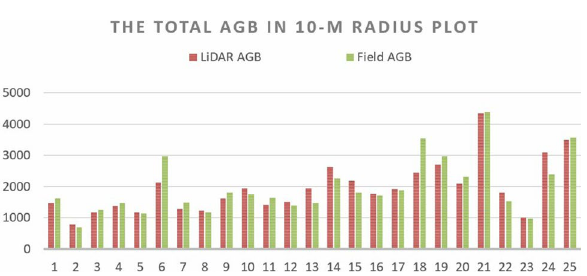
Figure 6. The total AGB computed by Model II (LiDAR AGB) and allometric model 2 (Field AGB) in each 10 m radius plot-level (in